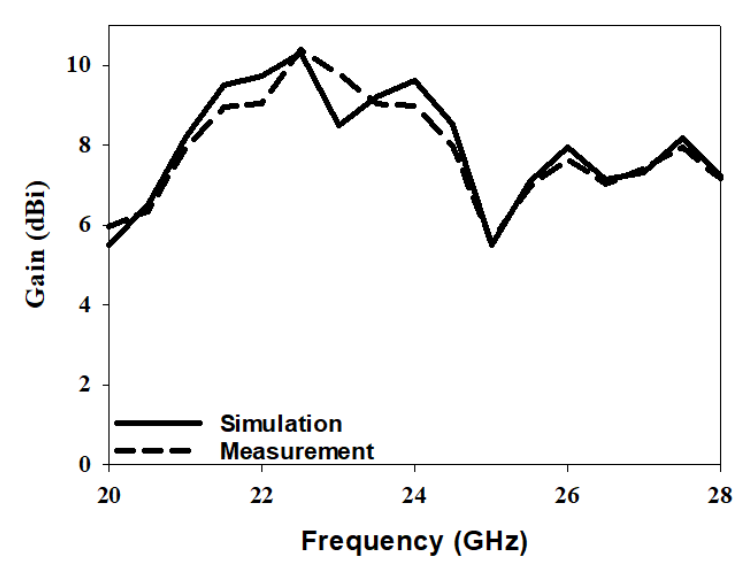
Figure 14. Realized gain of a hemispherical DRA placed on a grooved compound ground plane.